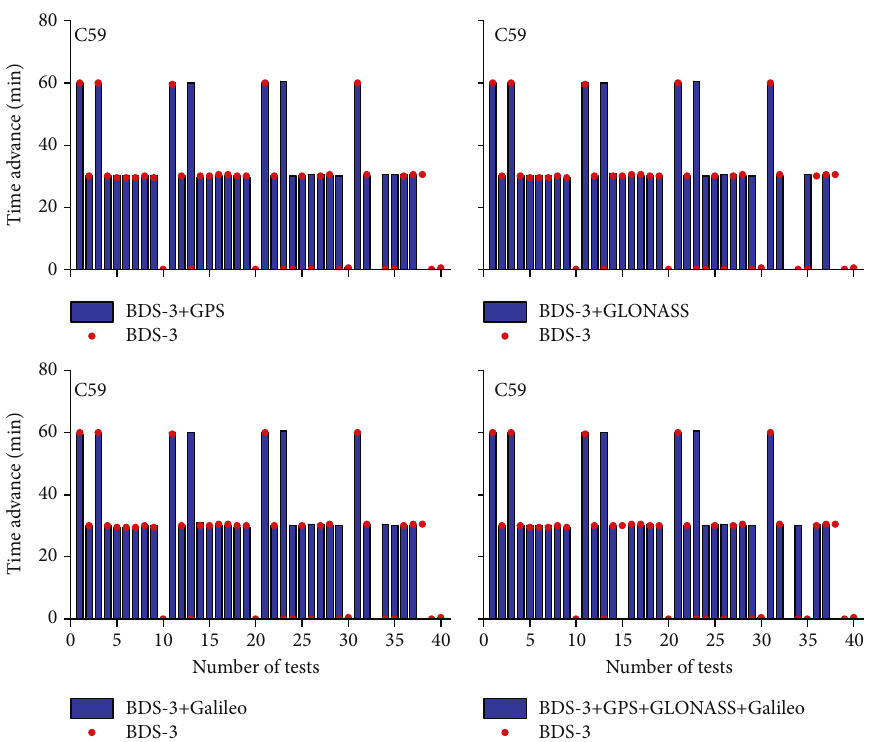
Figure 12: Comparison of detection results of C59 orbit maneuvering start times by di ff erent system combinations.